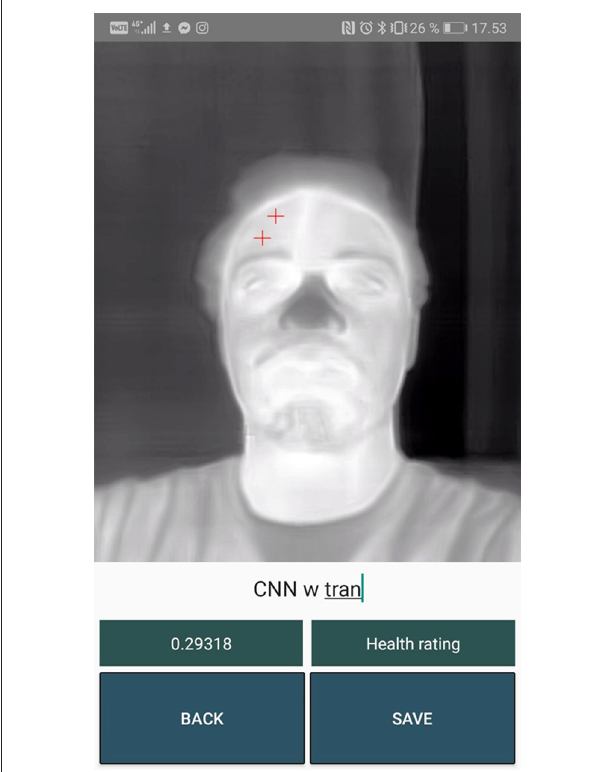
FIGURE 11 | Output markers for the CNN with transfer learning